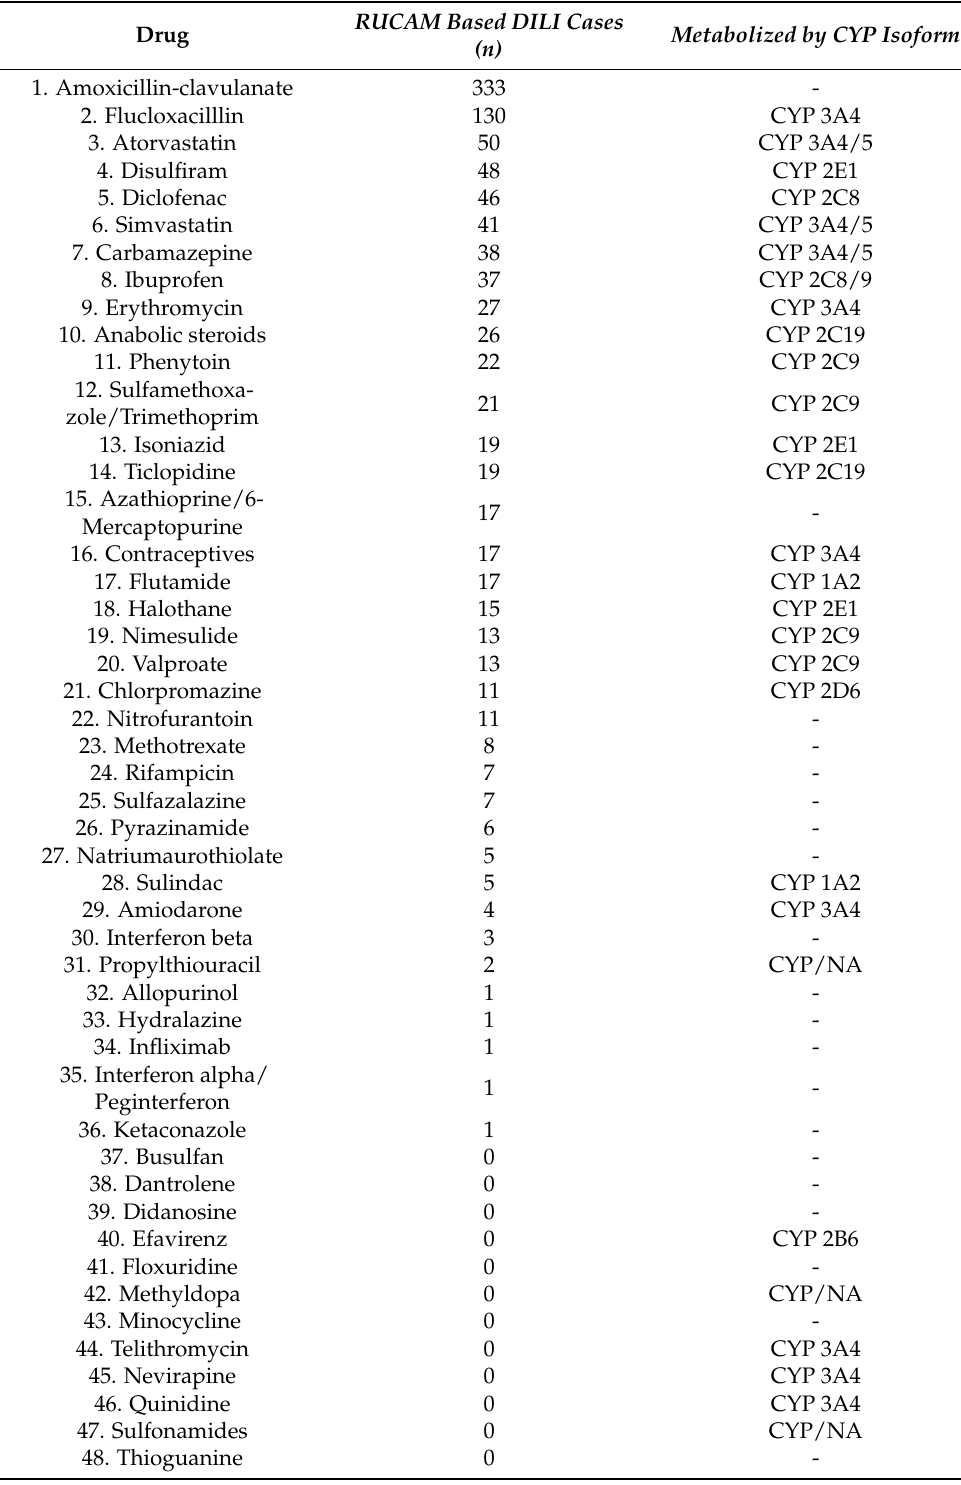
Table 2. Ranking of drugs causing iDILI with causality assessment of cases by RUCAM. Modified from previous publications [3,5,21]. Listed are the top ranking 48 drugs implicated in causing 3312 iDILI cases with verified causality using RUCAM [3]. The predominant CYP isoforms but not minor isoforms involved in drug metabolism are listed, with references provided in an earlier report [5,21]. CYP isoforms and nonCYP pathways were derived from clinical and experimental studies, as mentioned in original reports and published listings. Abbreviations: CYP, Cytochrome P450; DILI, Drug induced liver injury: NA, not